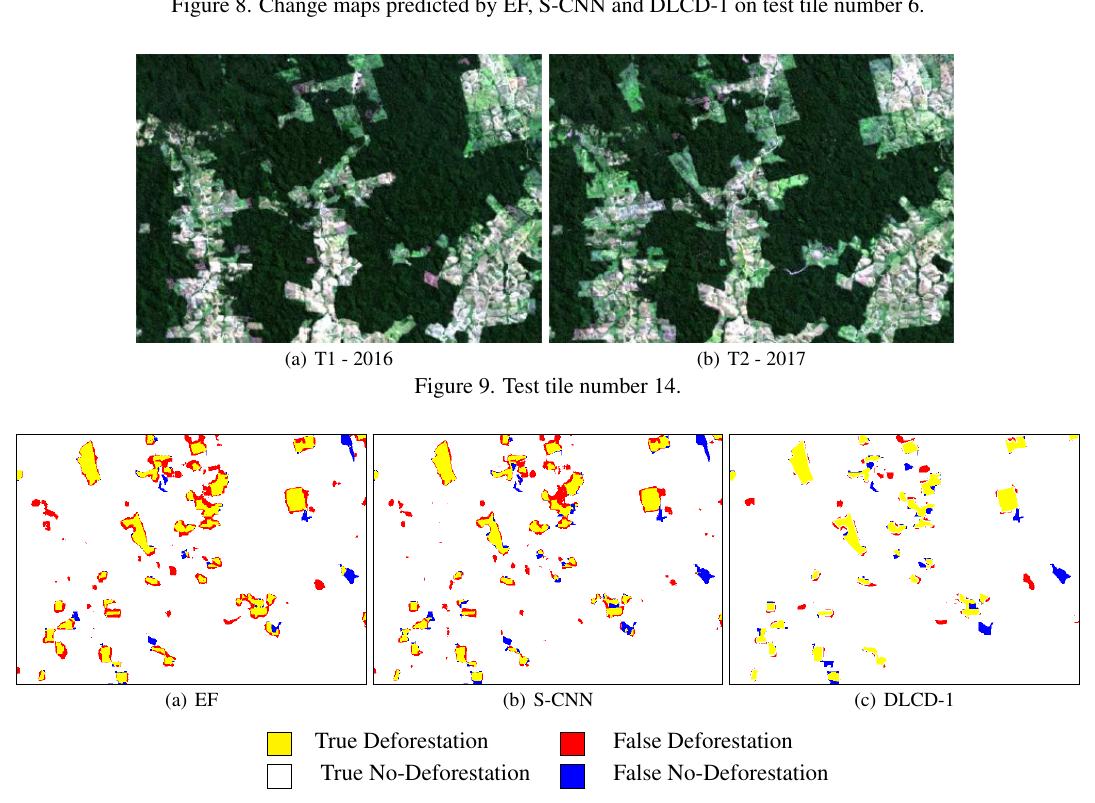
Figure 10. Change maps predicted by EF, S-CNN and DLCD-1 on test tile number